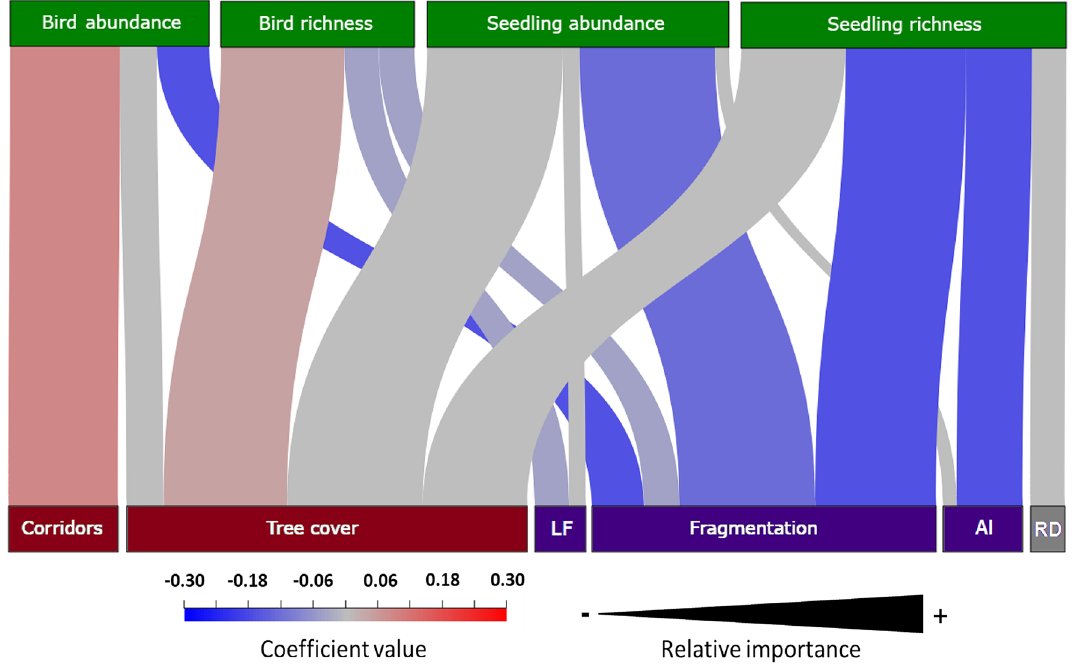
Figure 2. Graphical representation of landscape drivers influencing abundance and richness of highly forest- dependent birds and late-successional tree seedlings in restoration plots in southern Costa Rica. Red boxes indicate landscape metrics with positive effects, blue with negative effects and gray with almost neutral effect. The blue-red gradient represents the coefficient value of the average model that is positive or negative for that factor, respectively. Landscape metrics are the ones included in 95% set of models. The relative importance ( Ʃ wi ) is indicated by the width of the link (0 > Ʃ wi < 1). LF = live-fences, AI = patch aggregation index, RD = remnant tree